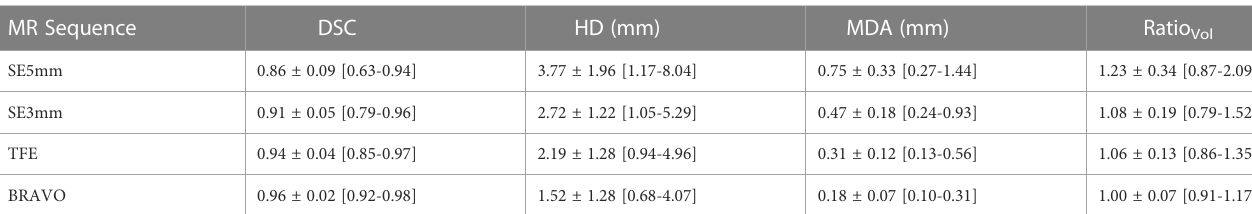
TABLE 3 Comparison of observer delineated versus ground truth contours using DSC, HD, MDA, and Ratio vol. . MR